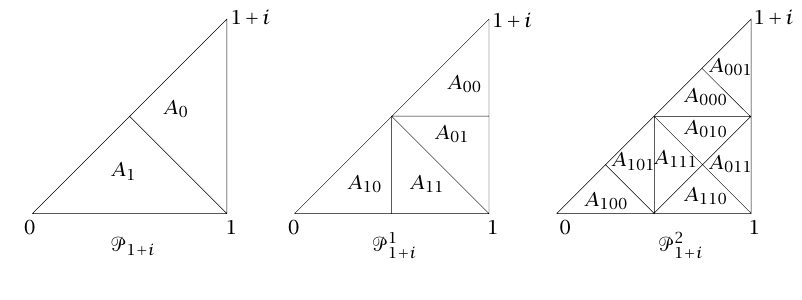
Figure 6.1 . Partitions for (cid:13) T 1 + i